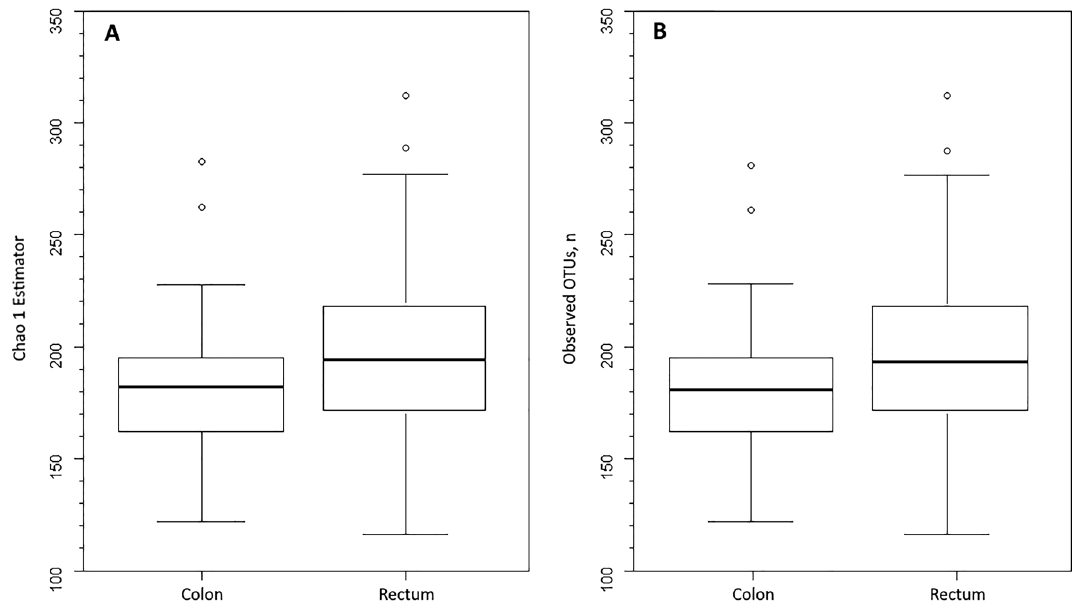
Figure 1. Microbiota diversity in resected colorectal mucosa from patients with colorectal cancer. Data grouped by tumor site, according to the V4-V5-V6 dataset. ( A ) Chao1 estimator, P = 0.049, Kruskal–Wallis rank-sum test with continuity correction. ( B ) Number of observed operational taxonomic units (OTUs), P = 0.049. The box marks the interquartile range, and the central horizontal line marks the median. Outliers (extreme values, > 1.5 times the interquartile range) are shown as circles.